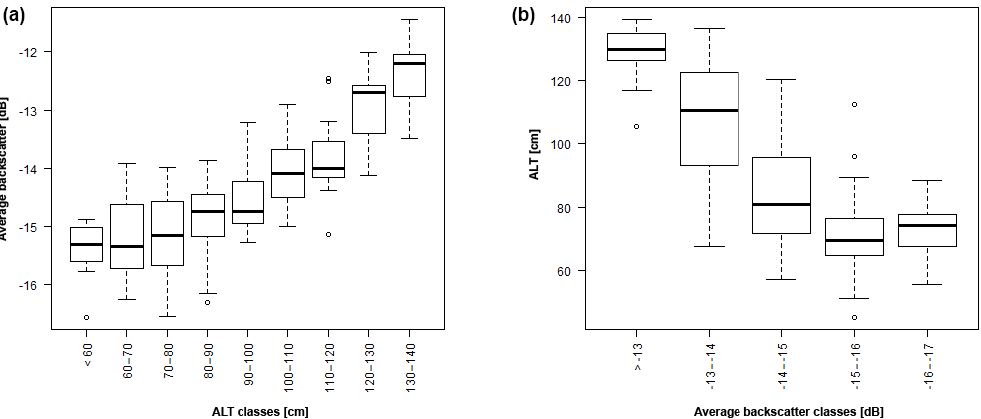
Figure 4. Box plots showing median, minimum and maximum values; first and third quartile and outliers of the ALT; and backscatter values of the sites VD-1, VD-2 and VD-3. Left: σ 0 statistics for ALT classes (10cm). Right: ALT statistics for backscatter classes (1dB).